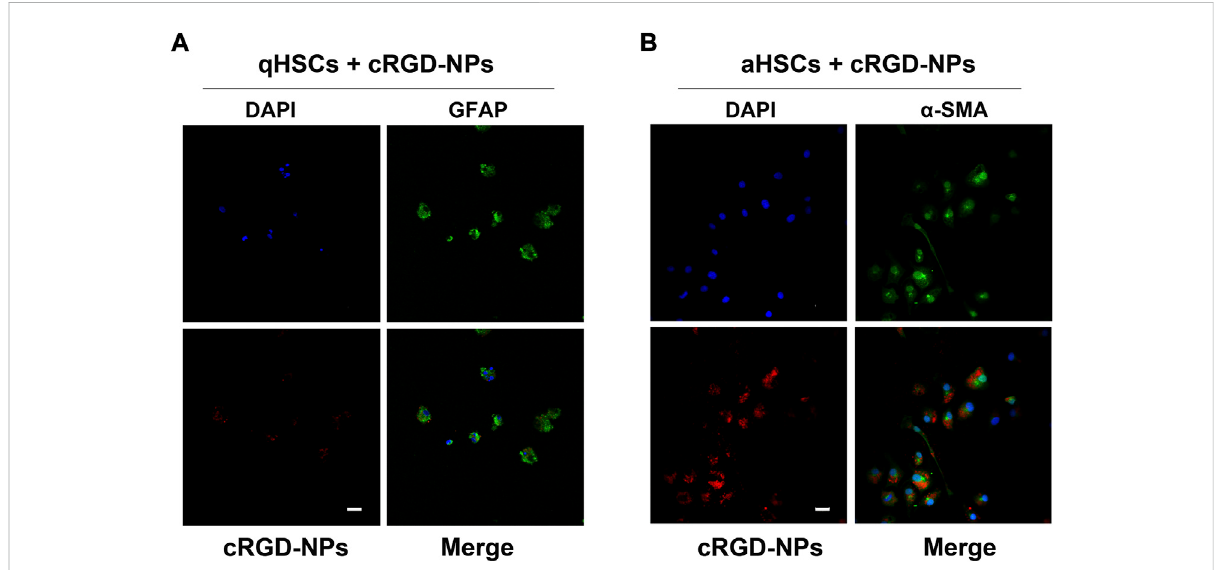
FIGURE 5 Representative fl uorescent images of qHSCs (A) and aHSCs (B) incubated with 25 mg/ml of cRGD-PLGA-Fe 3 O 4 -PFOB NPs (red) solution for 30 min at 37 ° C in the dark (×400; Scale: 100 μ